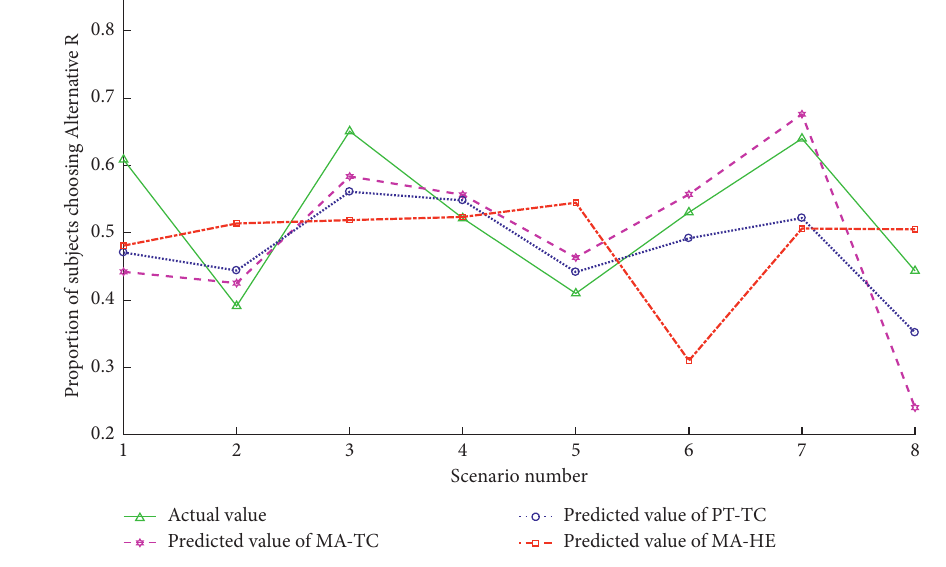
Figure 6: Forecast curve under deterministic conditions.